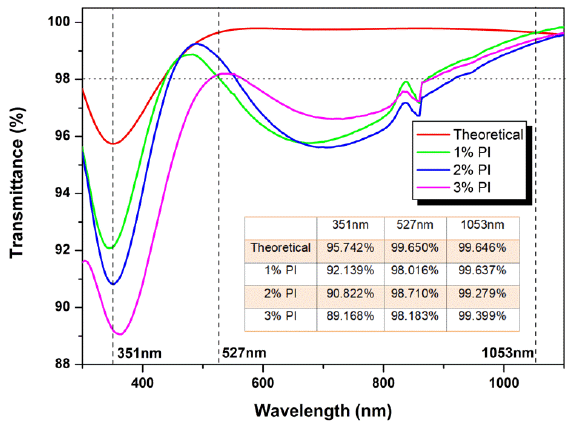
Figure 7. Transmission spectra of the dual-layer consolidated coating system with (di ff erent PI concentrations) and without PI (theoretical